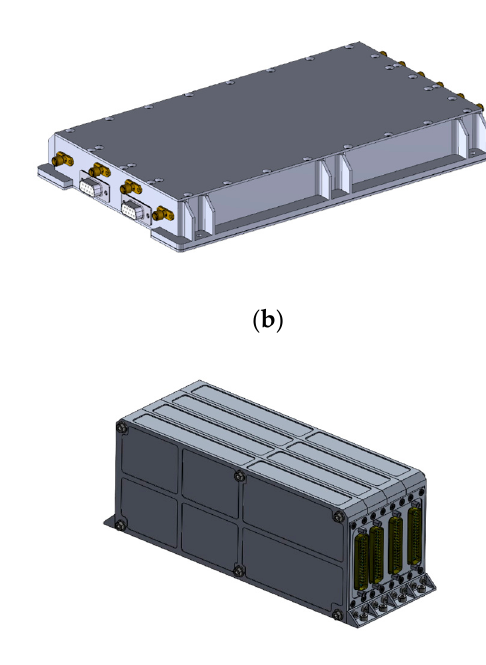
Figure 7. Mode transition diagram of the S-STEP SAR payload. Based on the above-mentioned iterative design optimization process, a brief over- view of the key parameters of the S-STEP SAR payload is presented in Table 2. The simu- lation and analysis of the SAR system design were performed using the SAR system de- sign tool, as described in Section 6. The dimensions of the designed antenna were 1970 × 1060 mm. The essential concepts of the innovative S-STEP satellite design include the bus–pay- load integrated flat-panel-type structure and highly modularized SAR antenna with a tile structure. In addition, an efficient unit design with simplified and integrated functions, a fatigue-life prediction methodology for electronic printed circuit boards (PCB), a dedi- cated VFOD, and a unique thermal control based on passive thermal control hardware are also applied. The hardware and software of the SAR payload were designed to achieve the given